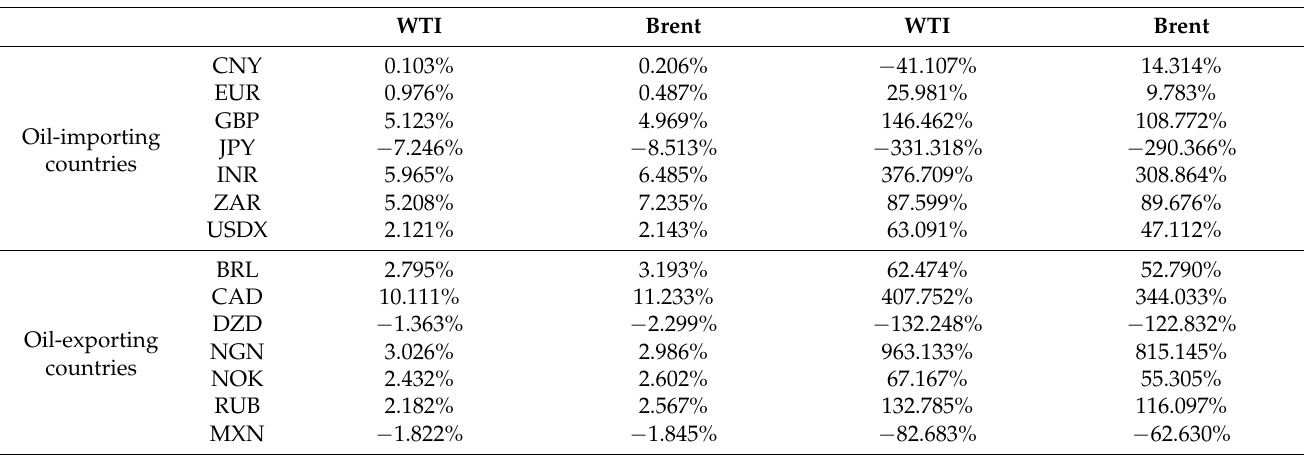
Table 4. The means of dynamic % ∆ CoVaR between exchange rate market and crude oil market ( α = β =